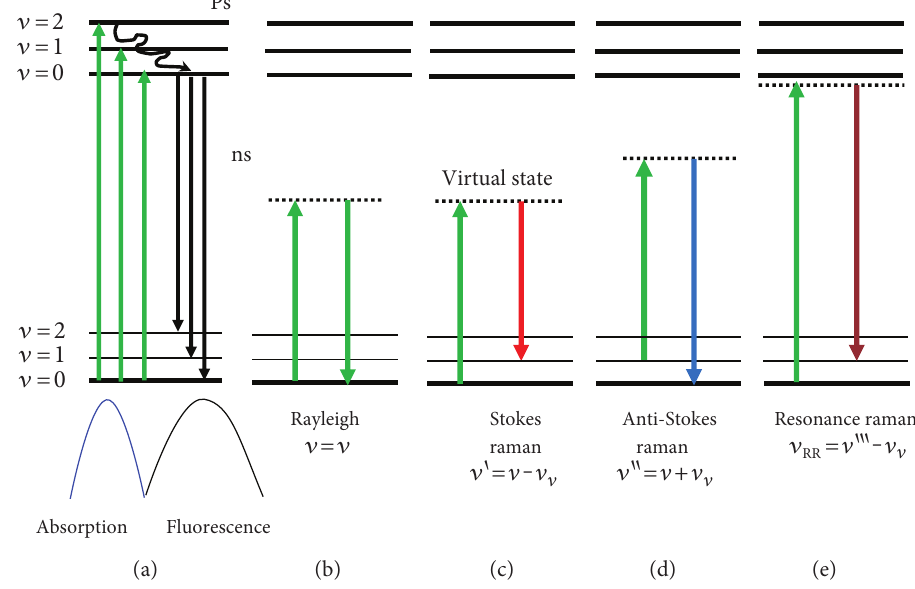
Figure 1: Schematic of energy level diagram of a molecule. S Rotational levels are within each vibrational level, but not shown here. (a) For Rayleigh scattering, (b) for Raman scattering Stokes, (c) for Raman scattering anti-Stokes, and (d) for resonance Raman